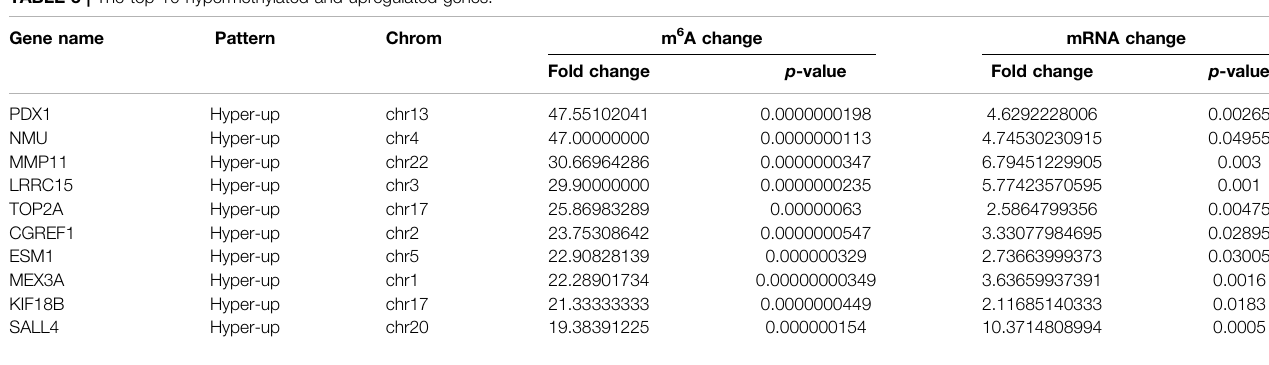
TABLE 3 | The top 10 hypermethylated and upregulated